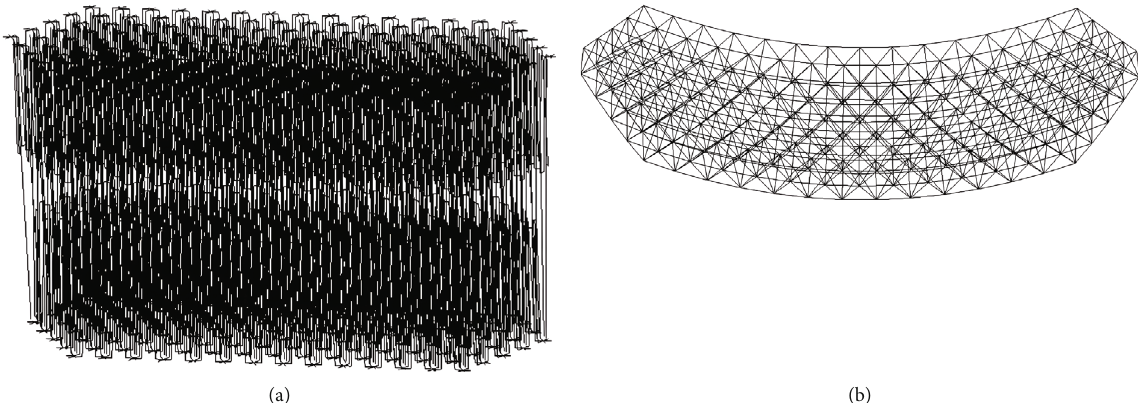
Figure 4: A tetrahedral truss antenna re fl ector. (a) Folded state. (b) Expanded